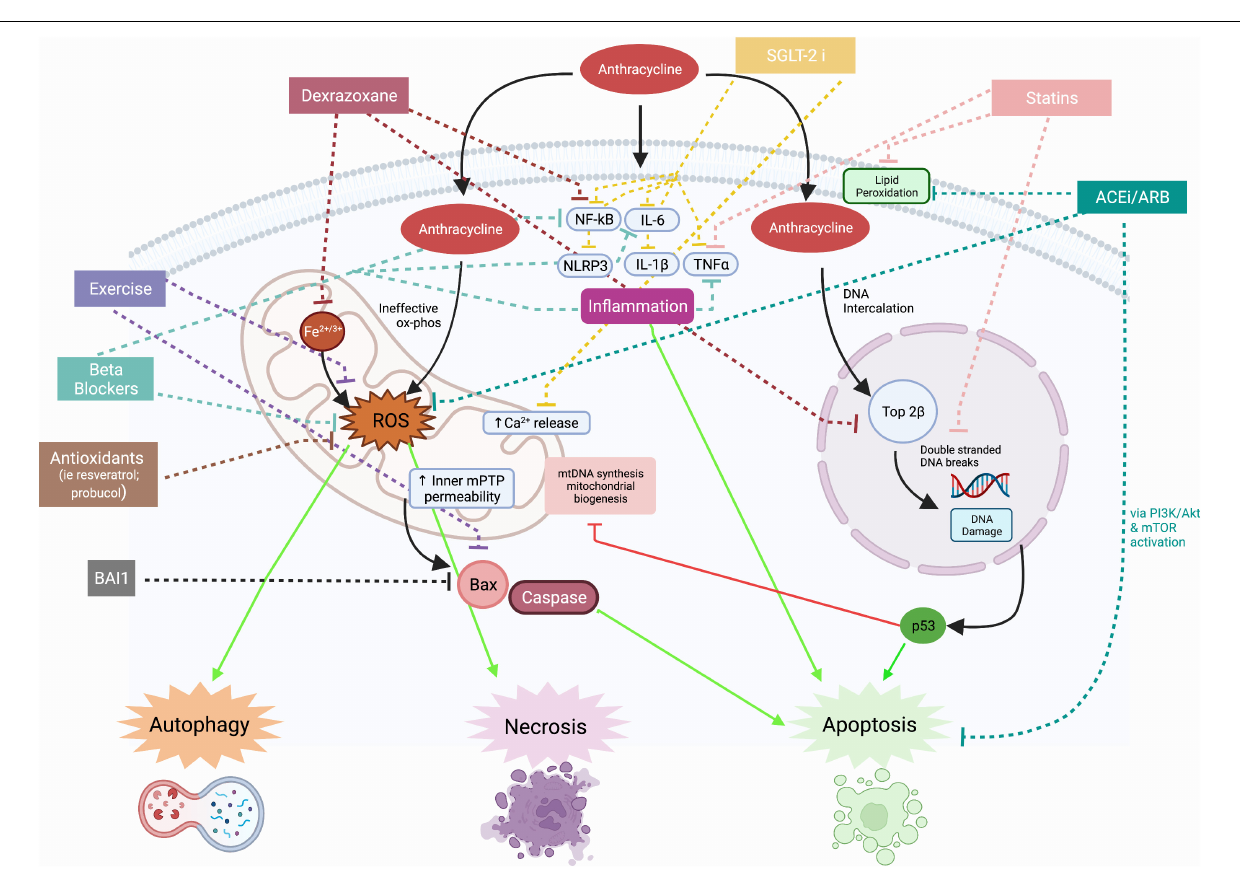
FIGURE 2 | Mechanisms of anthracycline cardiotoxicity and effects of therapies. Mitochondrial effects of anthracycline induced cardiotoxicity include production of reactive oxygen species, calcium dysregulation, impaired mitochondrial biogenesis, and disruption in mitochondrial membrane integrity, leading to release of apoptotic molecules such as bcl-2-associated X protein (Bax). The effects of anthracycline induced cardiotoxicity on nuclei include DNA intercalation and binding to Topoisomerase 2 β to cause double stranded DNA breaks. DNA damage releases pro-apoptotic factors such as p53. Anthracyclines increase the expression of pro-inflammatory cytokines such as NF-kB, IL-6, NLRP3, IL-1 β , and TNF- α . Proposed therapies have inhibitory effects on inflammation, reactive oxygen species production, DNA damage and apoptosis. Solid lines indicate mechanisms of anthracycline cardiotoxicity and dotted lines indicate mechanisms of proposed therapies. ACEi, angiotensin converting enzyme inhibitor; ARB, angiotensin II receptor blocker; BAI1, BAX activation inhibitor 1; Bax, bcl-2-associated X protein; Ca, calcium; Fe2+/3+, iron; IL, interleukin; mPTP, mitochondrial permeability transition pore; mtDNA, mitochondrial DNA; NF-kB, nuclear factor kappa B; NLRP3, NLR family pyrin domain containing 3; ox phos, oxidative phosphorylation; ROS, reactive oxygen species; TNF α , tumor necrosis factor alpha; Top2 β , topoisomerase 2 β ; SGLT2i, sodium glucose cotransporter 2 inhibitor; PI3K, phosphinositide 3-kinase; Akt, protein kinase B; mTOR, mammalian target of rapamycin. Created with